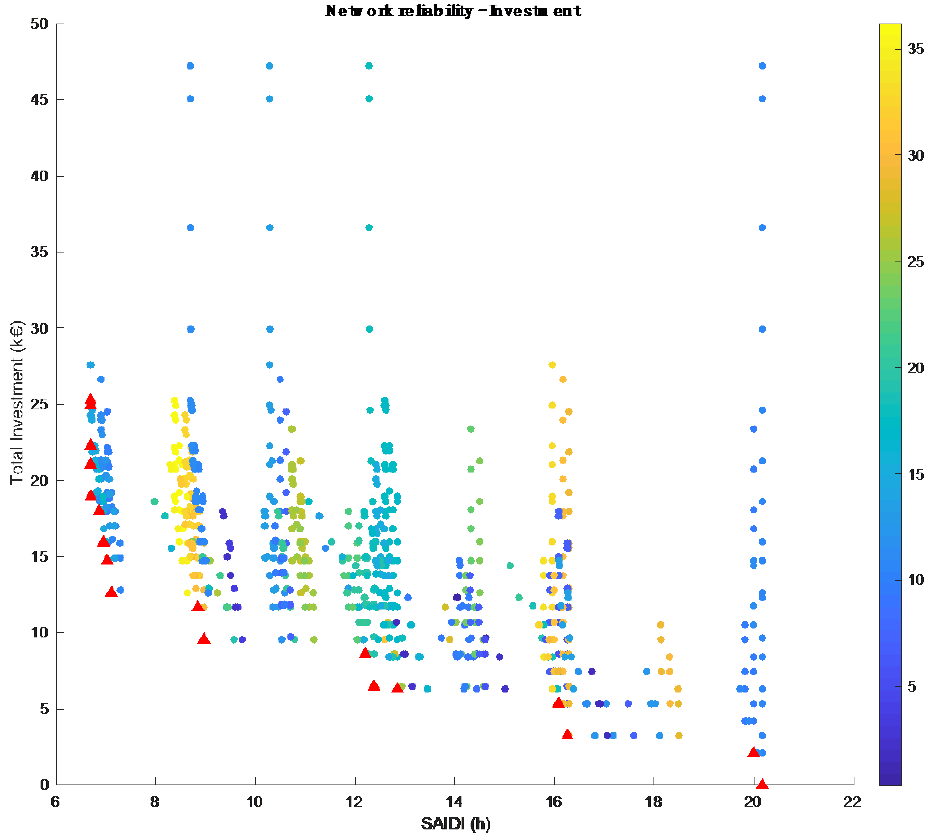
Figure 8. Network solutions for the case study network (colors represent the standard deviation of zonal SAIDI in percentage).